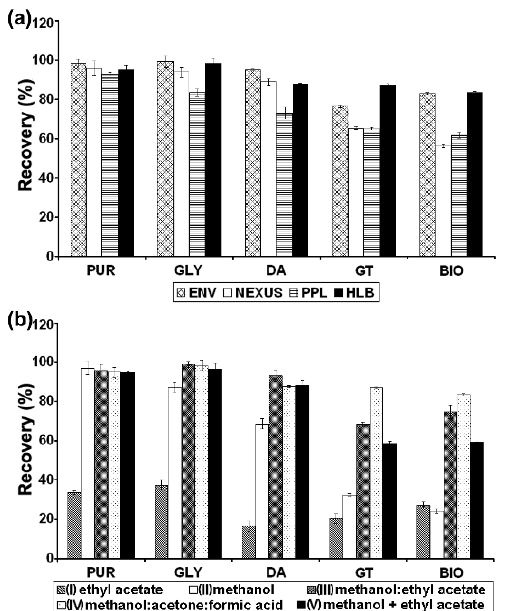
Figure 6. Recoveries of the tested compounds extracted from human urine spiked at the standards mixture using: (a) various SPE cartridges; (b) Oasis HLB cartridges and different solvents for elution (I – V Method).